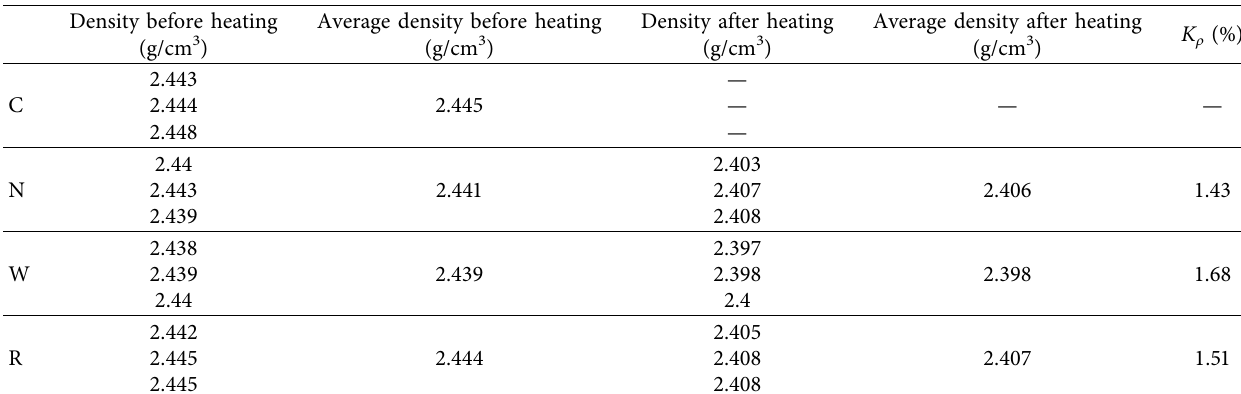
Figure 1: Specimen introductions. Table 1: Density.